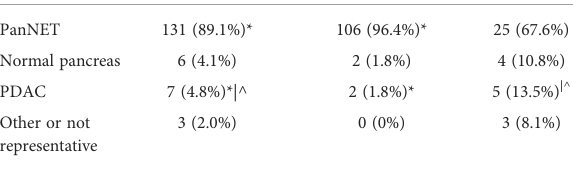
TABLE 5 Histopathological outcomes of all specimens. All specimens Resection